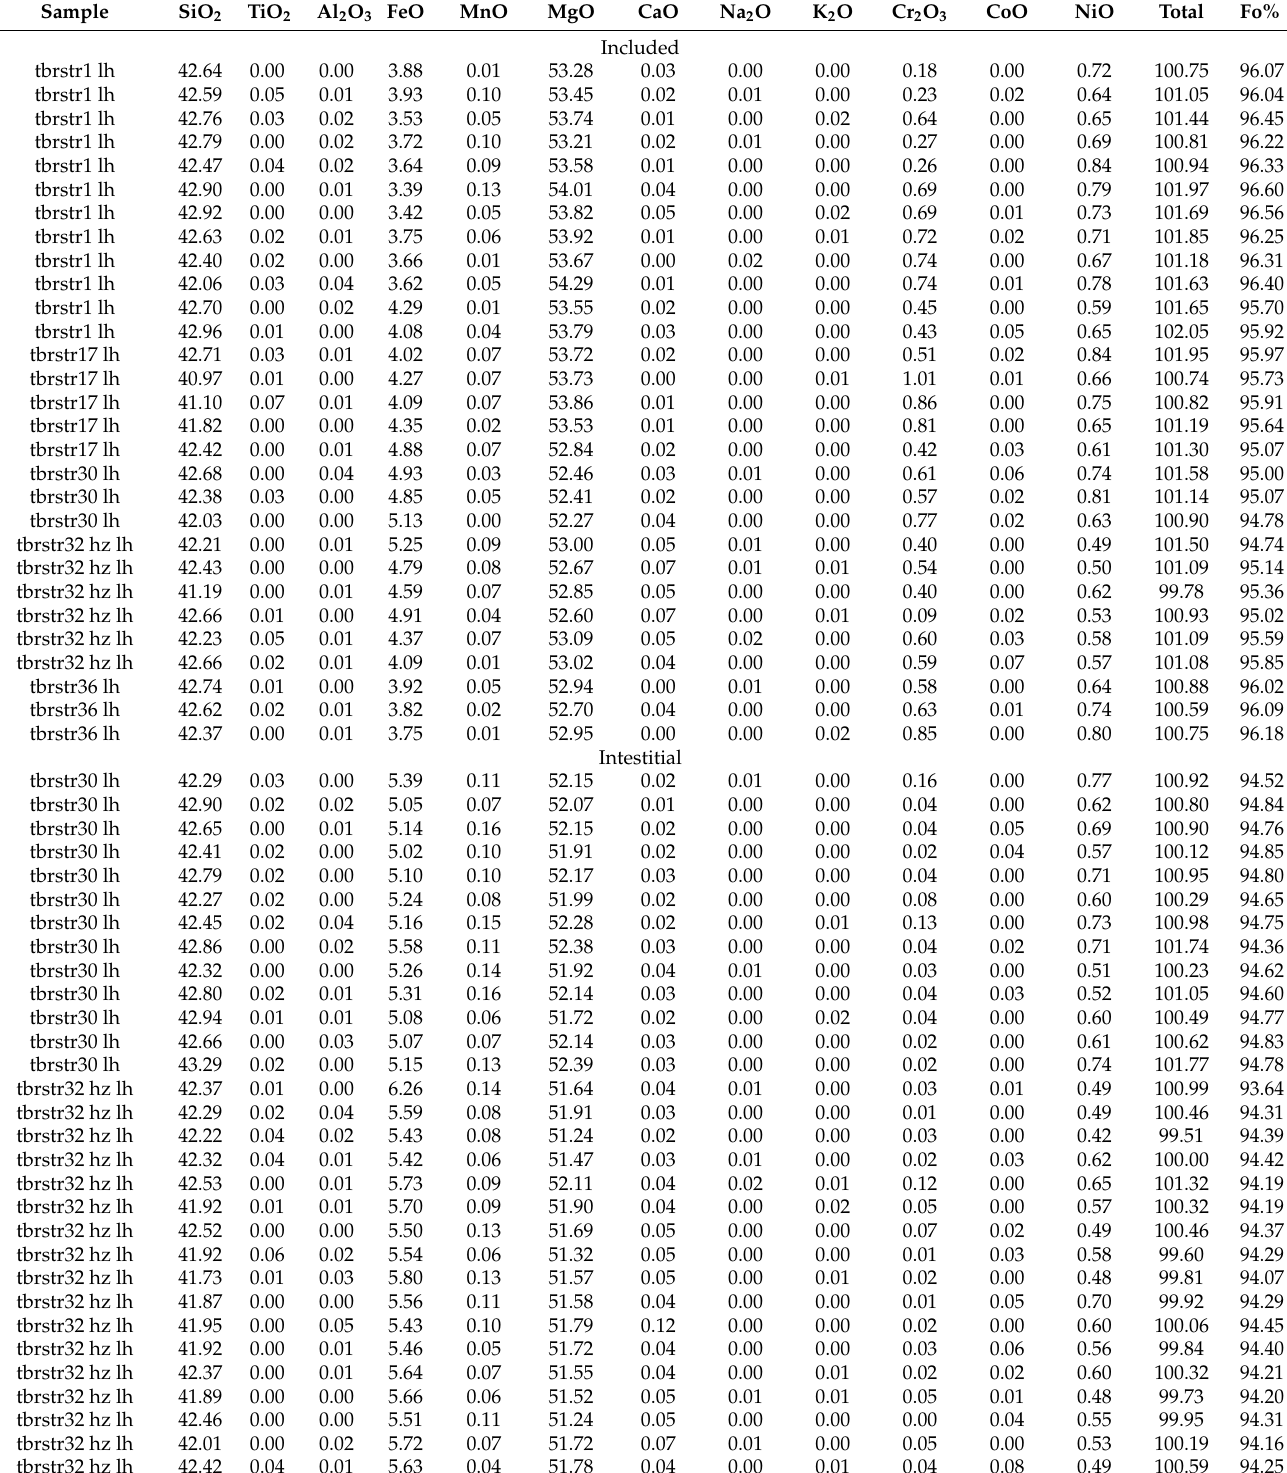
Table 2. Selected microprobe analyses of olivine (wt%) from chromitites of the Kabaena Island ophiolite.